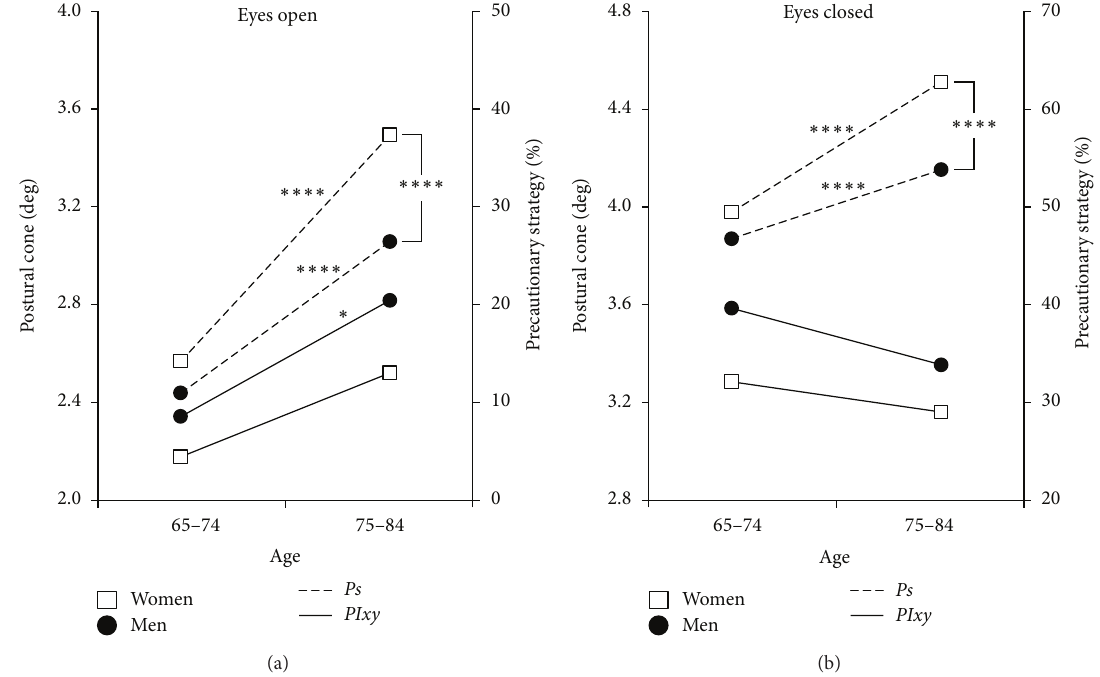
Figure 4: Single stance test: postural cone of instability ( PIxy ) and precautionary strategy ( Ps ) in males and females of different ages. (a) Eyes open. (b) Eyes closed. ∗∗∗∗ 𝑃 < 0.001 ; ∗ 𝑃 < 0.05